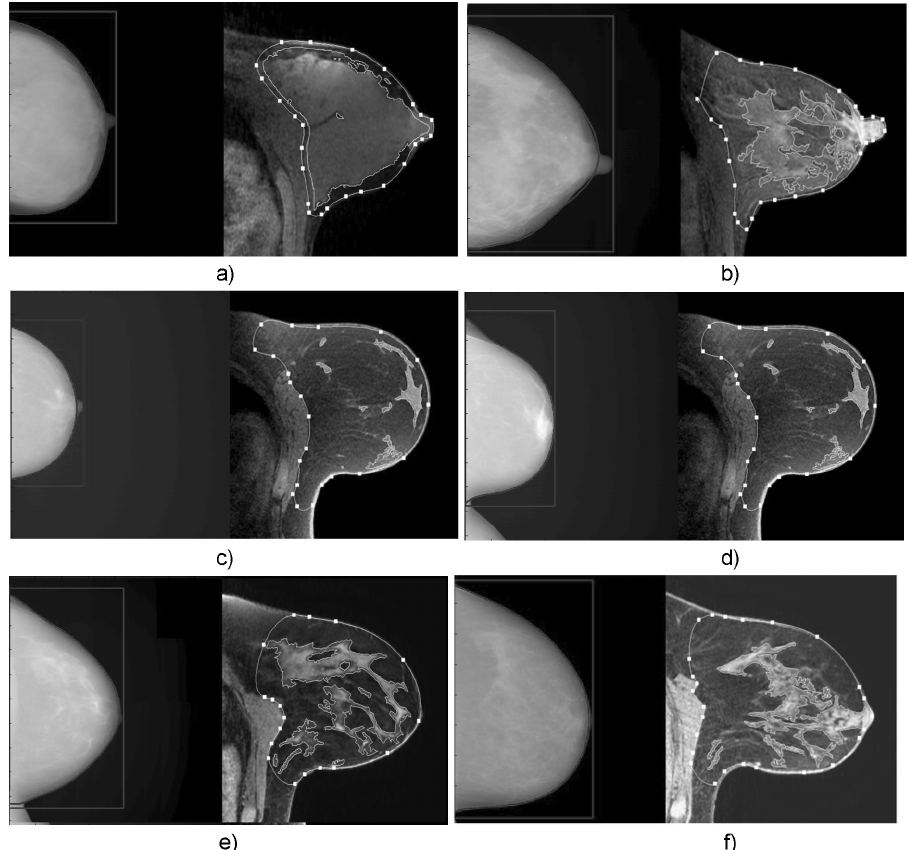
Figure 4. Six comparisons of the LCC mammograms to their respective left central breast axial-slice MR images on five different women (c and d are the same woman). The white line connecting points in the MR images define the total breast volume. The MRI fibroglandular volume is shown delineated with white lines without points. Solid data points 4a–4f in Figure 1 correspond to the image labels a–f. Compared to the mammographically-derived SXA values, a) MRI percent density is higher, b) MRI percent density is lower, c) MRI breast volume is higher, d) of the same woman as c (this mammogram not part of analyses, only here and measures plotted in Figure 1 to illustrate one reason for discrepancy between methods’ results), MRI breast volume is better segmented due to the breast being extended more into the mammographic image field, e) MRI breast volume is lower, f) all MRI measures of density and volume were in substantial agreement.